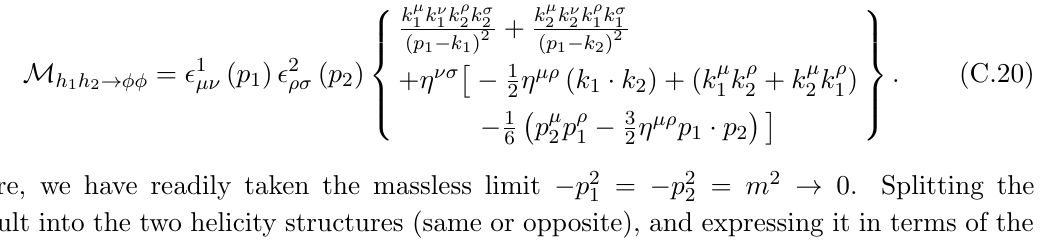
( k ; k ), as shown in (cid:12)gure 1 2 h 1 h 2 ! (cid:30)(cid:30)